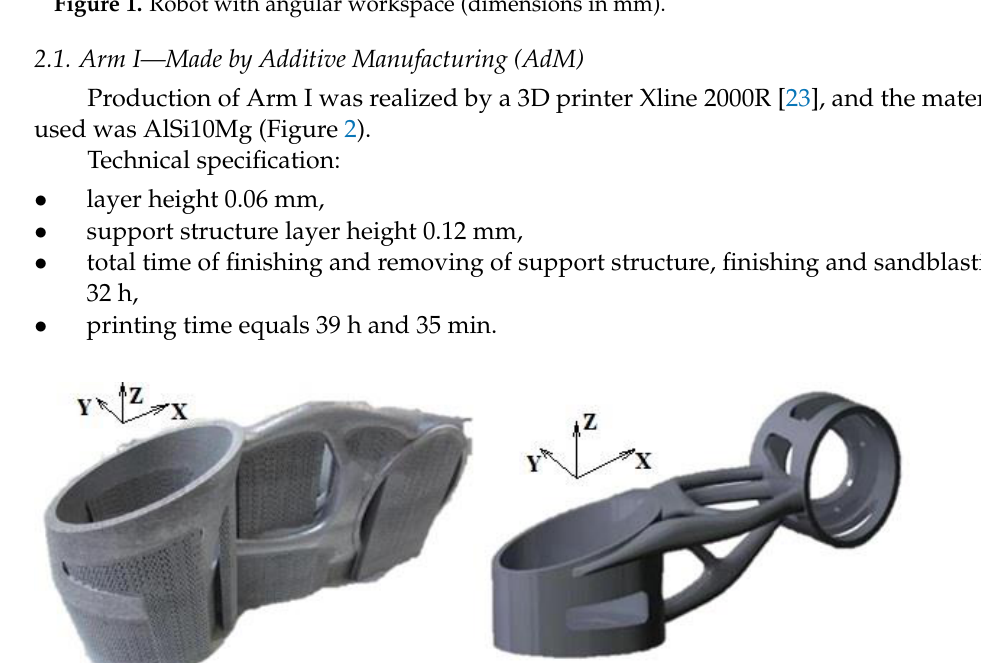
Figure 1. Robot with angular workspace (dimensions in mm).